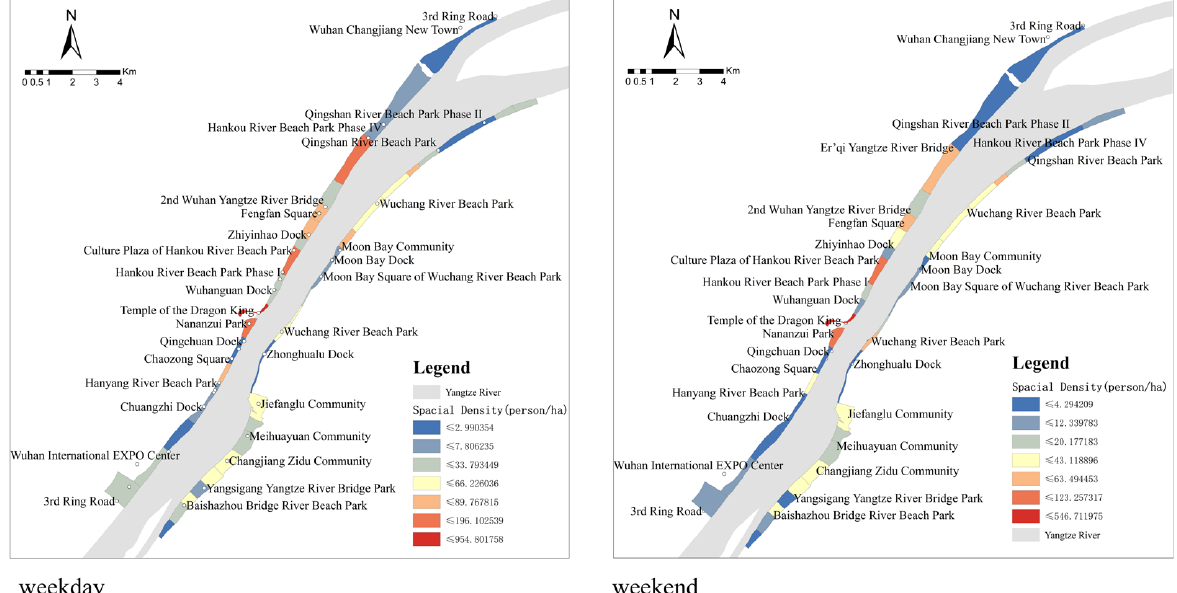
Figure 4. The space density distribution of the riverside area of Wuhan.